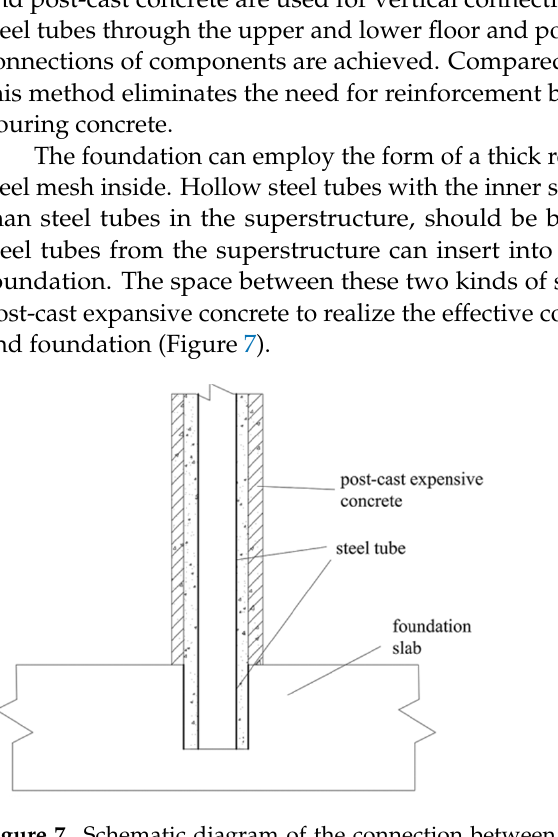
Figure 7. Schematic diagram of the connection between the foundation and the bottom vertical load-bearing unit.